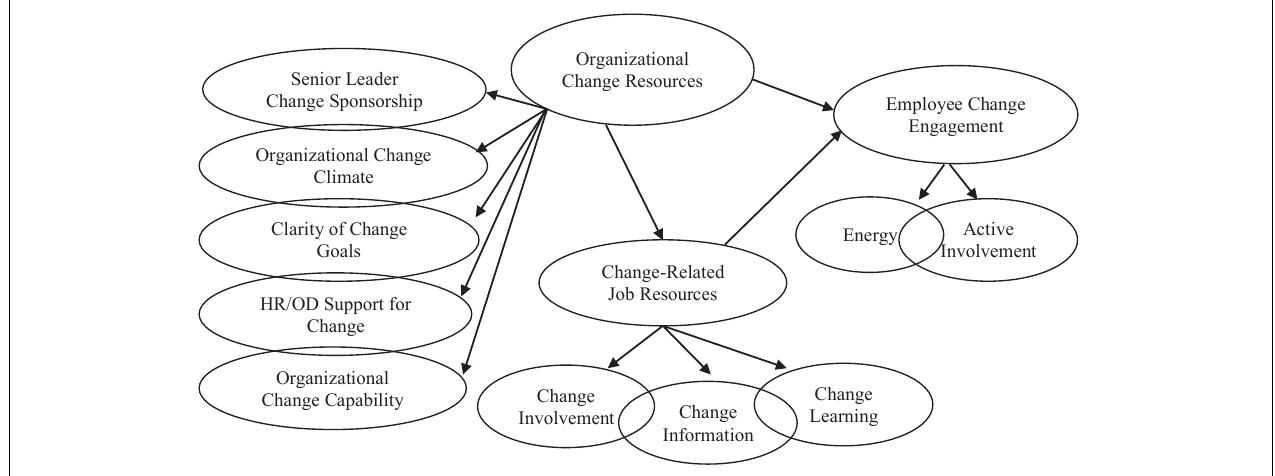
FIGURE 1 | Proposed model. Items, errors, and implied indirect effects not shown for ease of